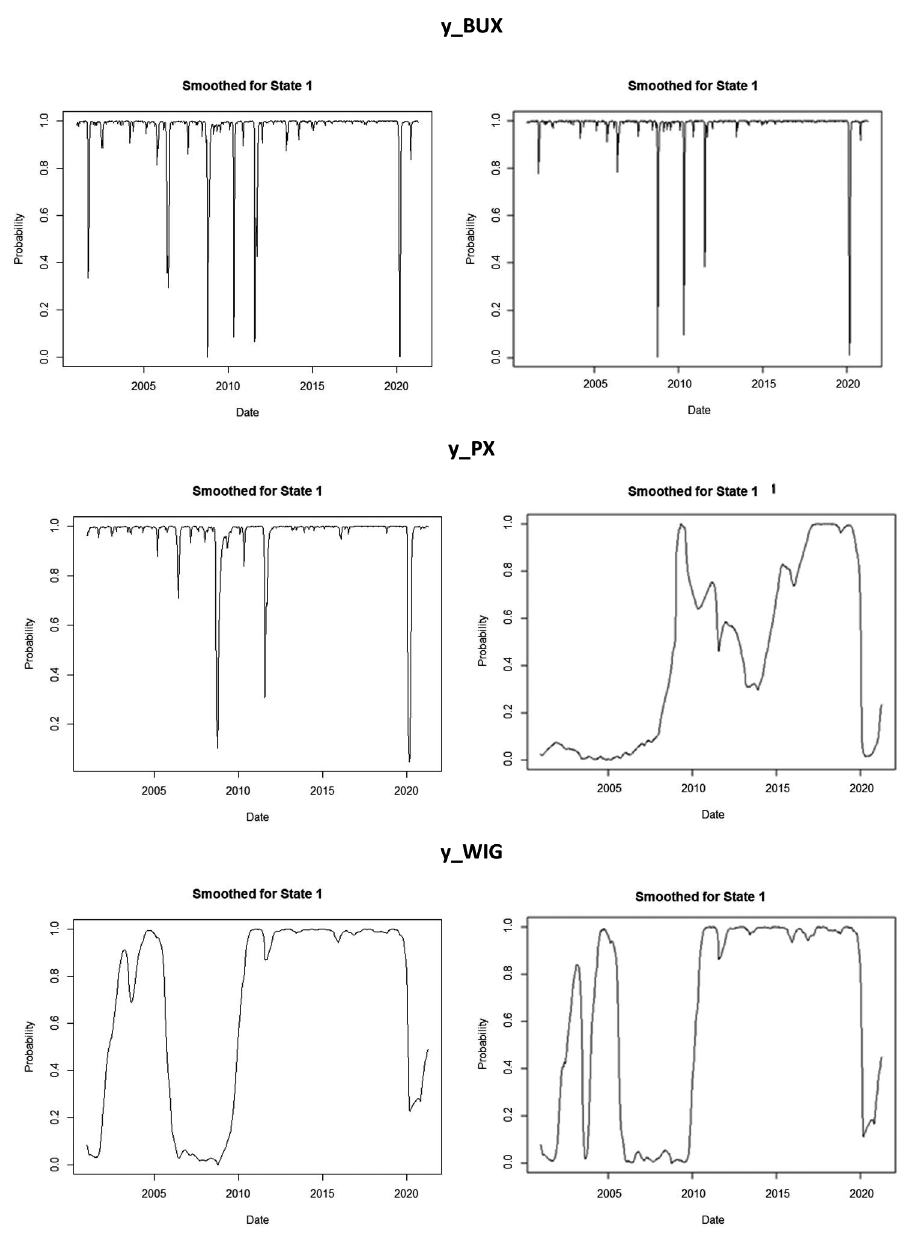
Figure 2. Smoothed probabilities for the regime 1: MS-GARCH (1,1) models with two regimes (left) and MS-GJR-GARCH (1,1) with two regimes (right) (source: own calculations in R, package